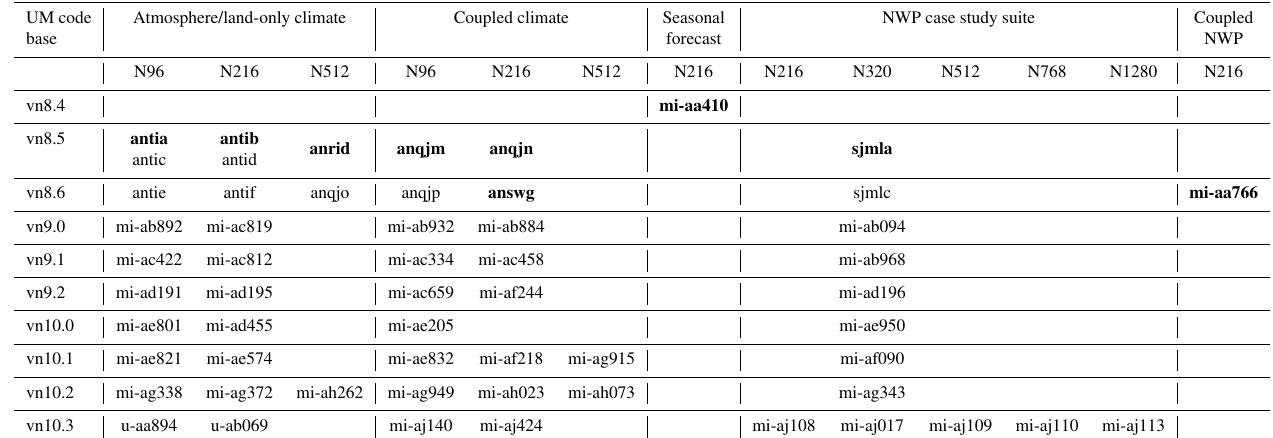
Table 6. Identifiers for a set of GA6.0/GL6.0 reference simulations across a number of UM code versions and systems/applications. Five letter identifiers beginning with a ... and s ... are Tcl/Tk-based UM user interface and cycling suite control system user interface jobs respectively. Six character identifiers beginning with mi-a ... are Rose suites held in the original Met Office internal repository and identifiers beginning with u-a ... are more recent Rose suites held on the Met Office Science Repository Service in which we now hold and develop the UM and JULES code. Identifiers marked in bold denote those used in the original assessment of the GA6.0